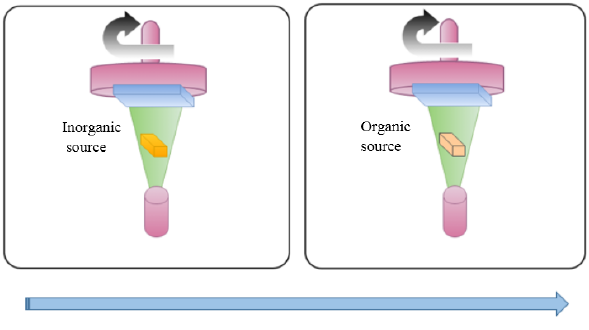
Figure 3: The sequential dual-source vapor deposition